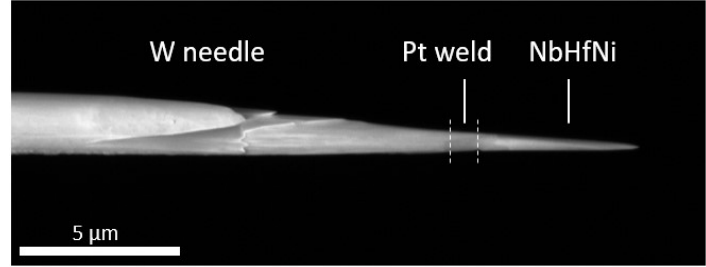
Figure 1. Scanning Electron Microscopy image of a Nb-Hf-Ni specimen after annular milling by FIB.